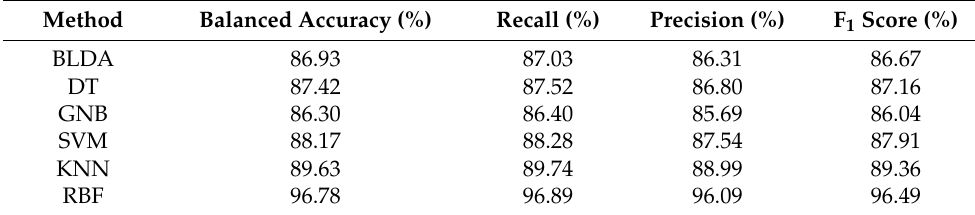
Table 2. Values of balanced accuracy, recall, precision, and F 1 score of the machine learning models and the proposed method implemented.